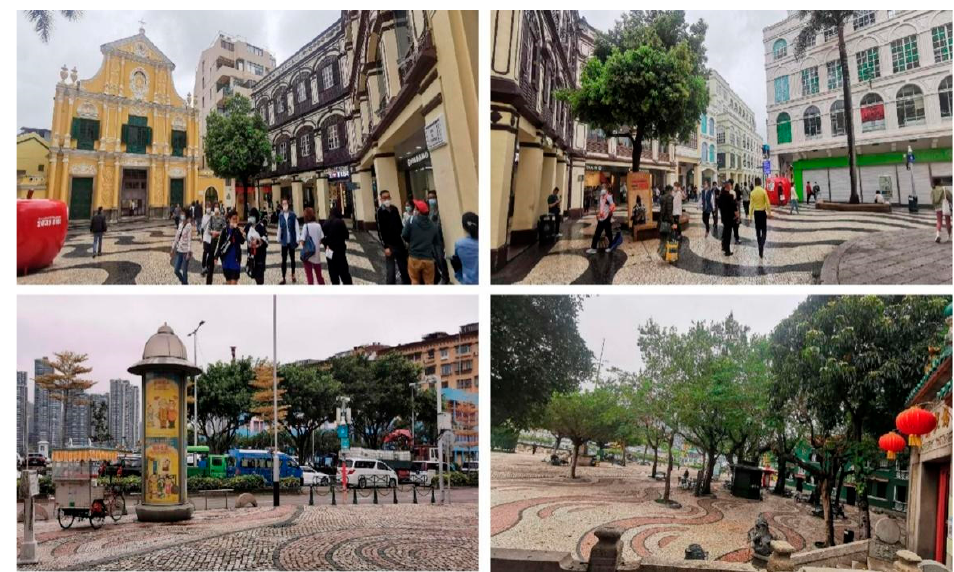
Figure 16. Largo do Pagode do Bazar and Adro de S. Lázaro.